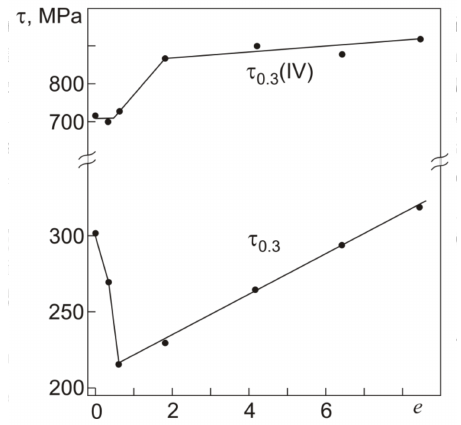
Figure 6. Yield stress τ 0.3 and critical stress τ 0.3 (IV) in torsion at 295 K for Ti 49.8 Ni 50.2 after abc pressing with di ff erent true strains e